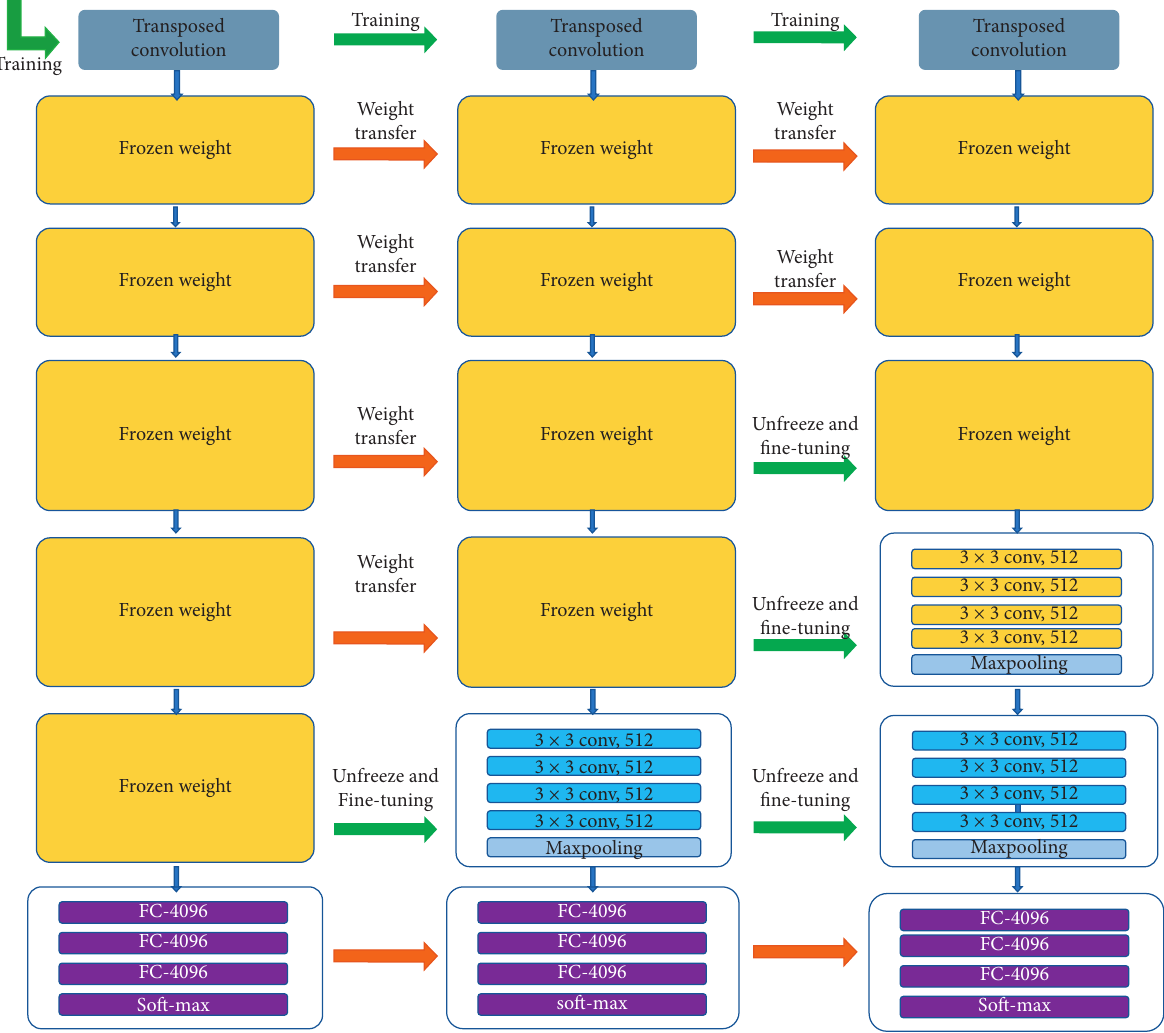
Figure 6: The process of the experiment.